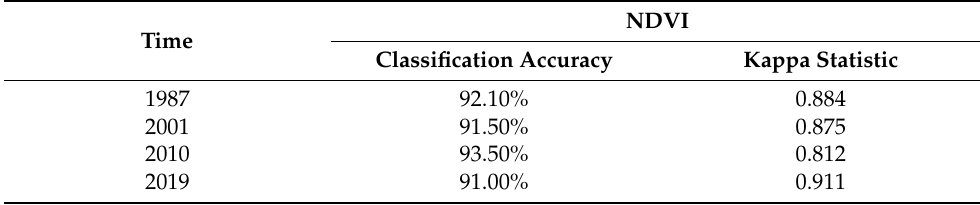
Table 5. Accuracy assessment and kappa statistics of multi-temporal data from NDVI classification